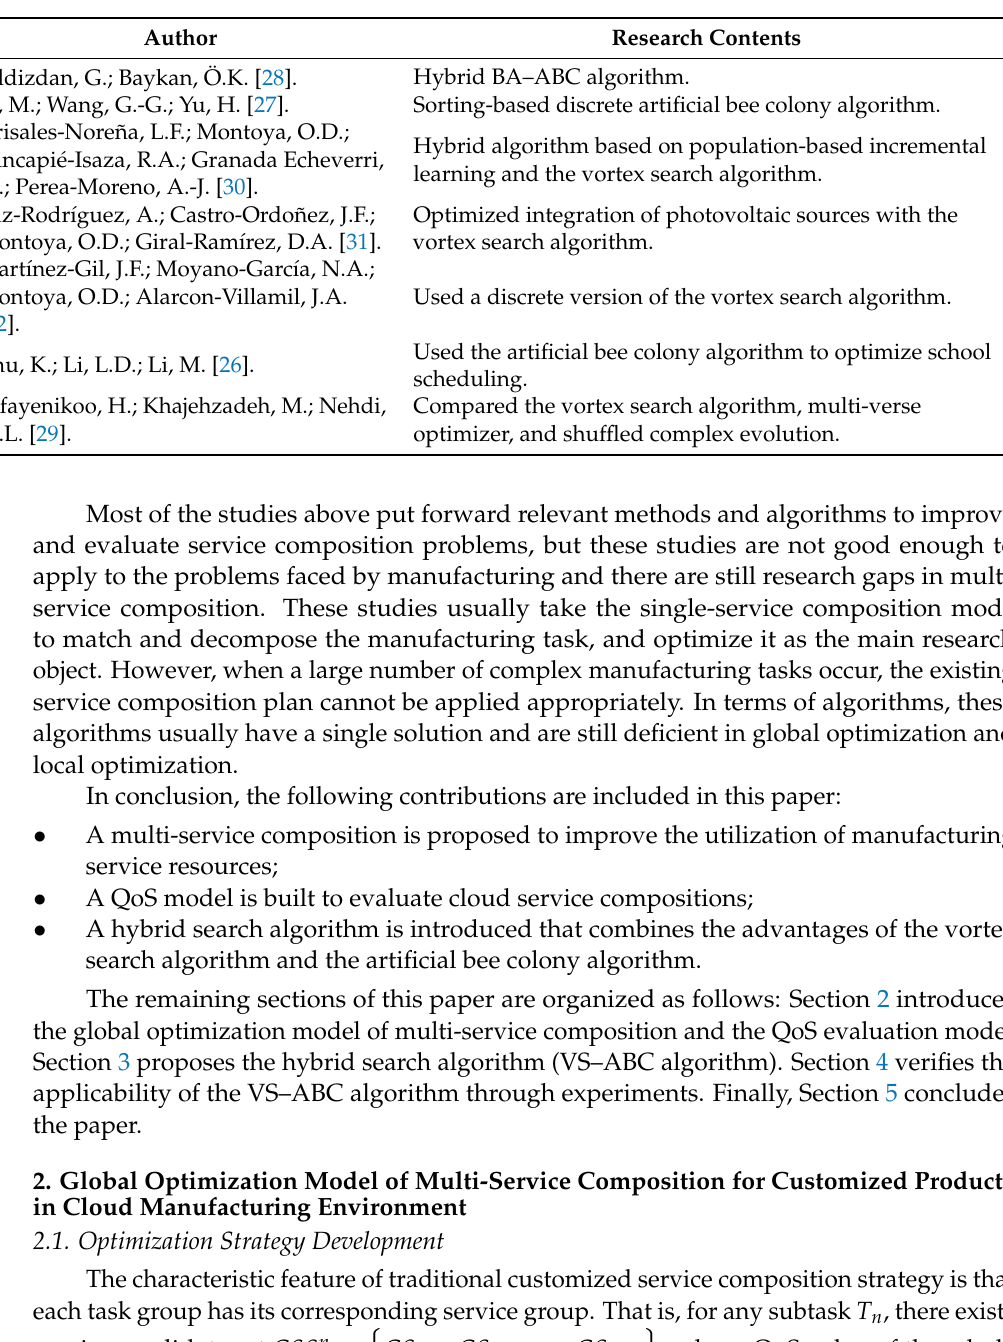
Table 3. Researchers and studies related to algorithm